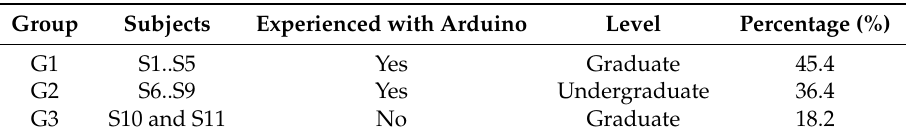
Table 4. Description of participant